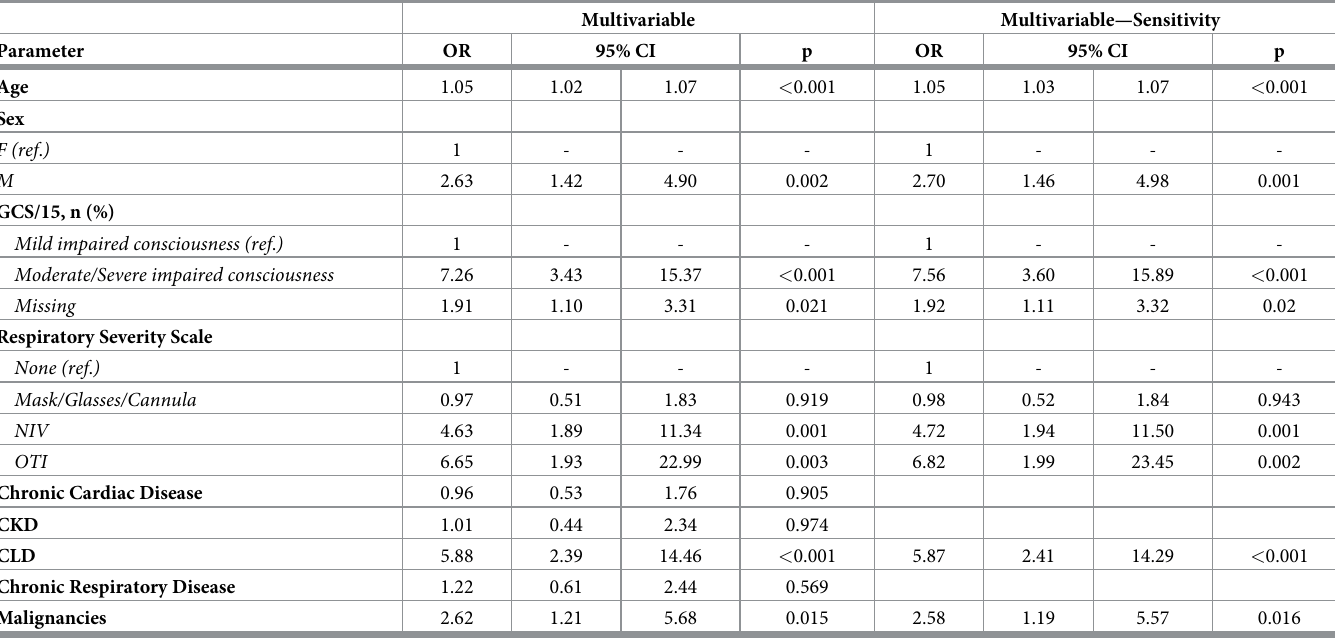
Table 3. Multivariable models on mortality outcome in our COVID-19 study cohort (n = 618).